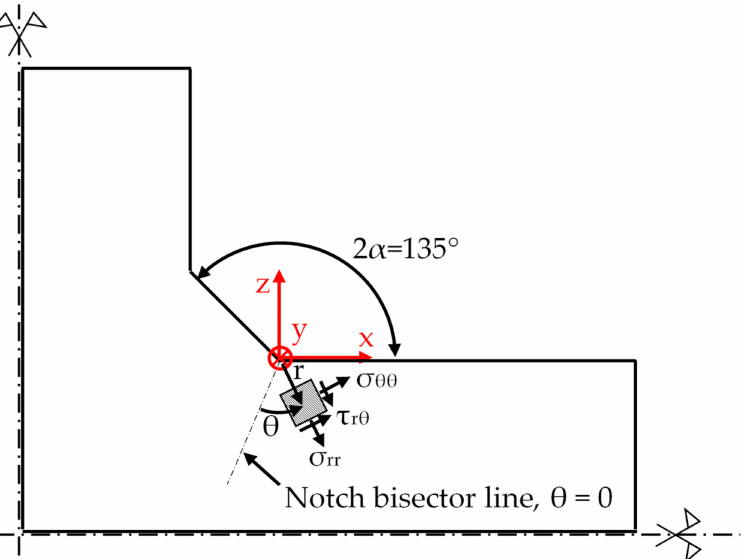
Figure 1. Geometrical assumptions to define the Residual Notch Stress Intensity Factor (R-NSIF) at the weld toe of a cruciform full-penetration welded joint: the sharp V-notch opening angle 2 α is typically 135 ◦ , while the tip radius is null. The polar reference system is centered at the weld toe and residual stress components are